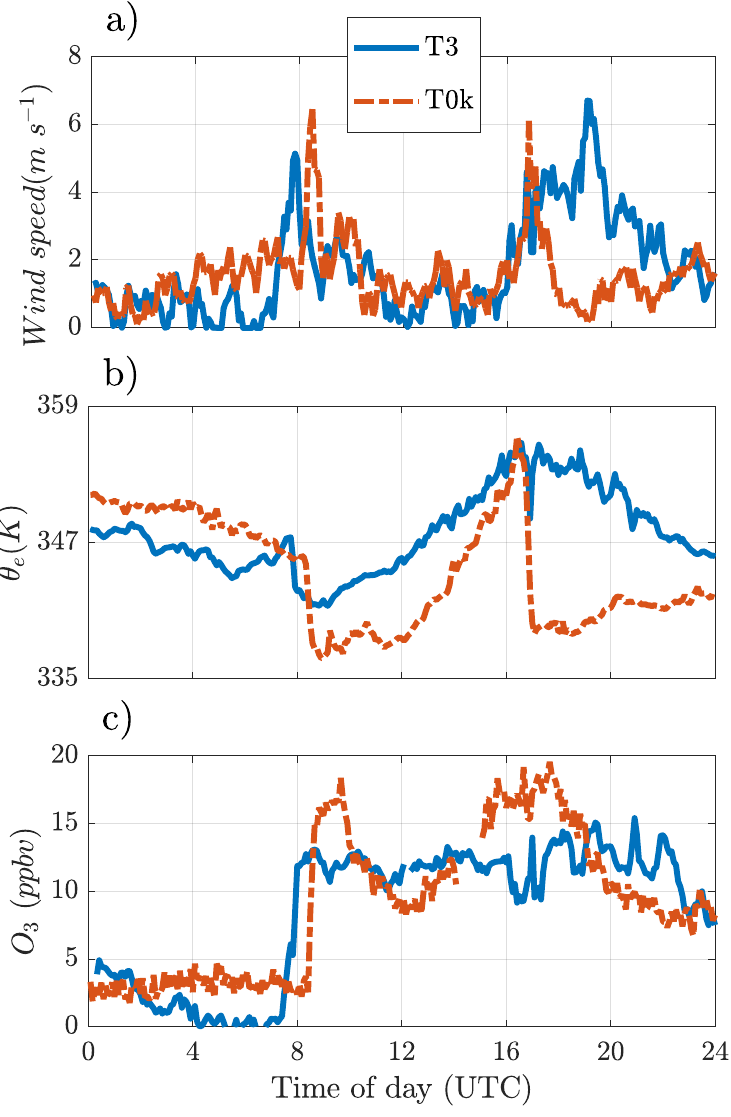
Figure 3. Time series of: ( a ) Horizontal wind speed, ( b ) equivalent potential temperature ( θ e ), and ( c ) ozone (O 3 ) measured on 21 April 2014, above the Manacapuru-T3 experimental site (blue line) and T0k (dashed red line), during the displacement of squall lines above the analyzed